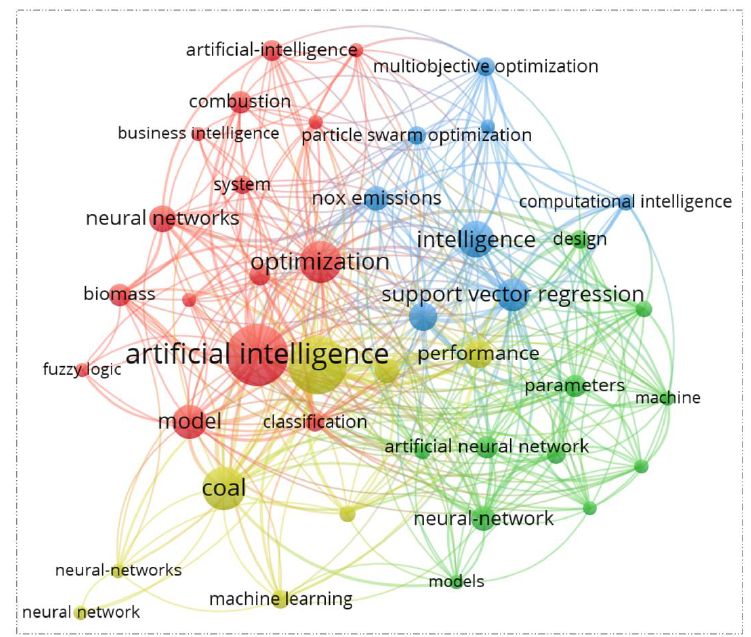
Figure 1. Research hotspots of intelligent coal mines from 2010 to 2020.